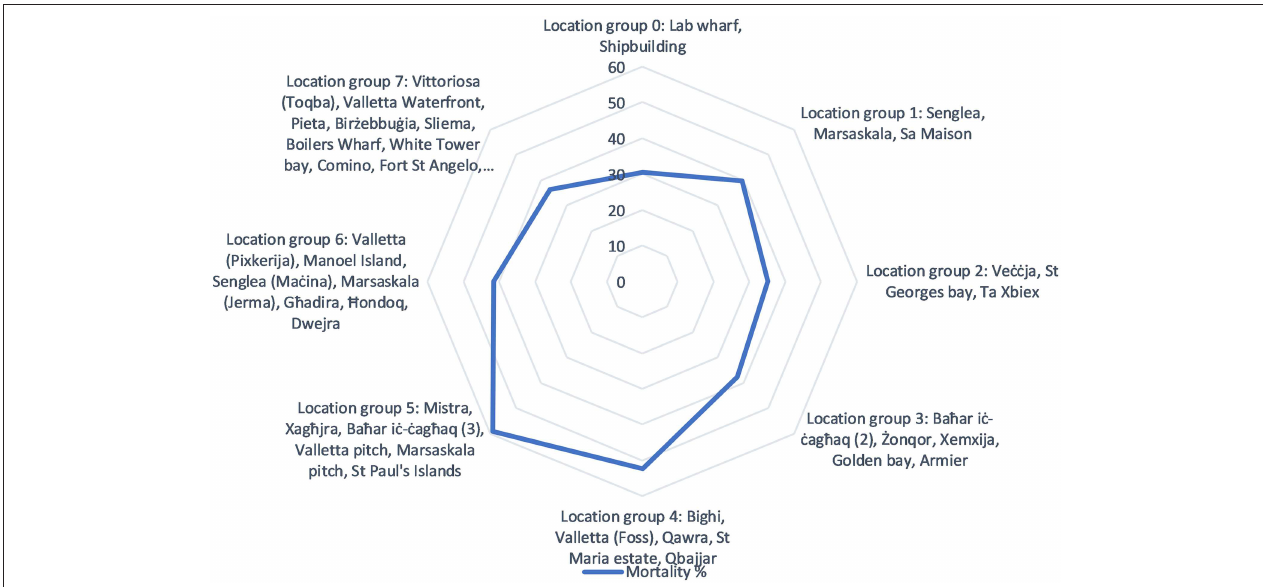
FIGURE 2 | Locations were grouped into 7 categories based on their mean mortality for the linear regression model. Location groups 0, 1, 2 and 3 and 7 were not significant predictors of the mortality rate. The group estimated means from the linear regression model are shown on the web